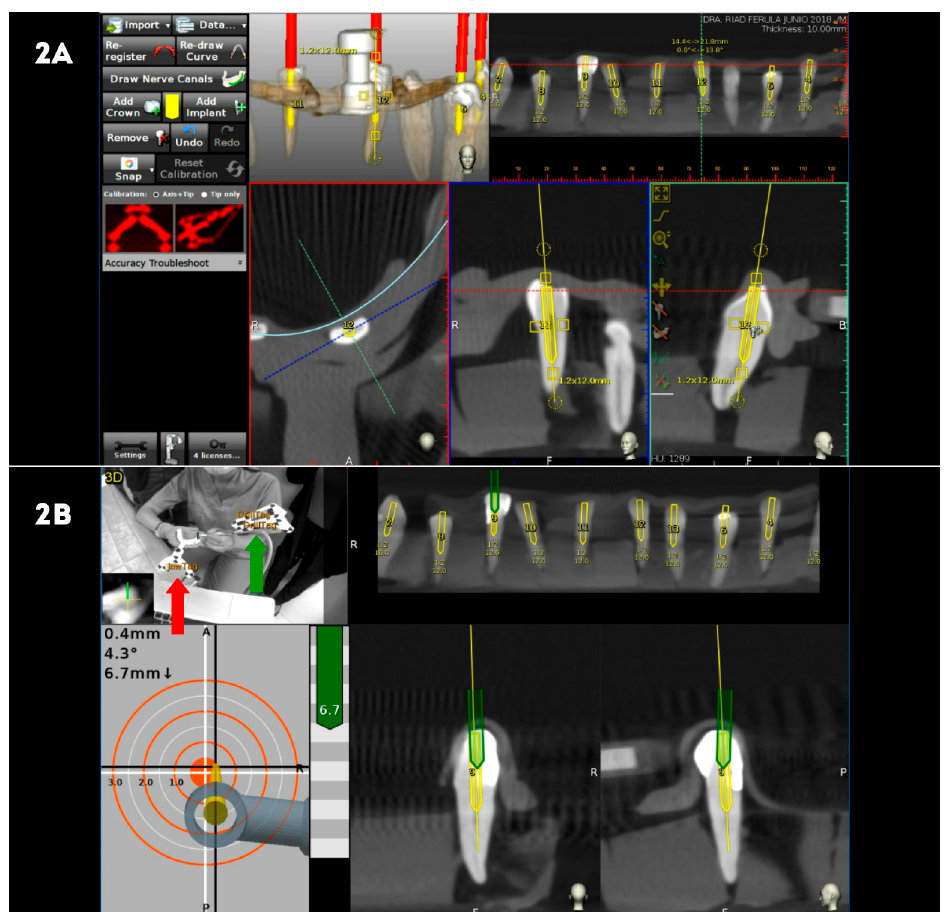
Figure 2. ( A ) Planning endodontic access cavities with treatment planning software of computer-aided dynamic navigation system (yellow cylinders), and ( B ) performing endodontic access cavities (green cylinders) controlled in all planes and depth with the black-and-white jaw tag fixed over the dental surface of the teeth with the thermoplastic template and the black-and-white drill tag (red arrow) attached to the high-speed handpiece (green arrow).